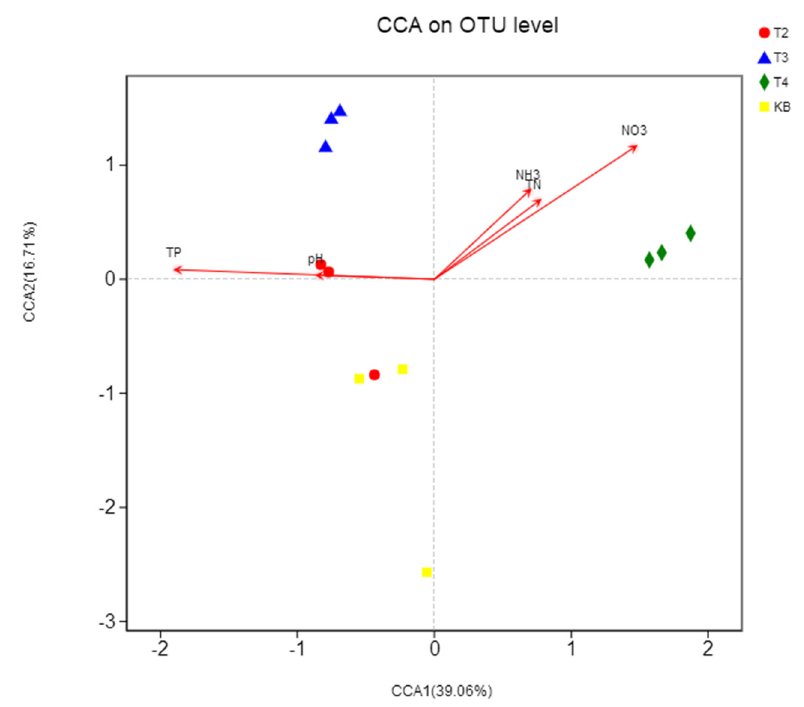
Figure 5. Correspondence Analysis (CCA) of the 16SrRNA gene sequencing data and physicochemical properties of bistriazine ring derivative wastewater. The arrow direction and size show the extent of the influence, positive and negative, on the microbial community composition.